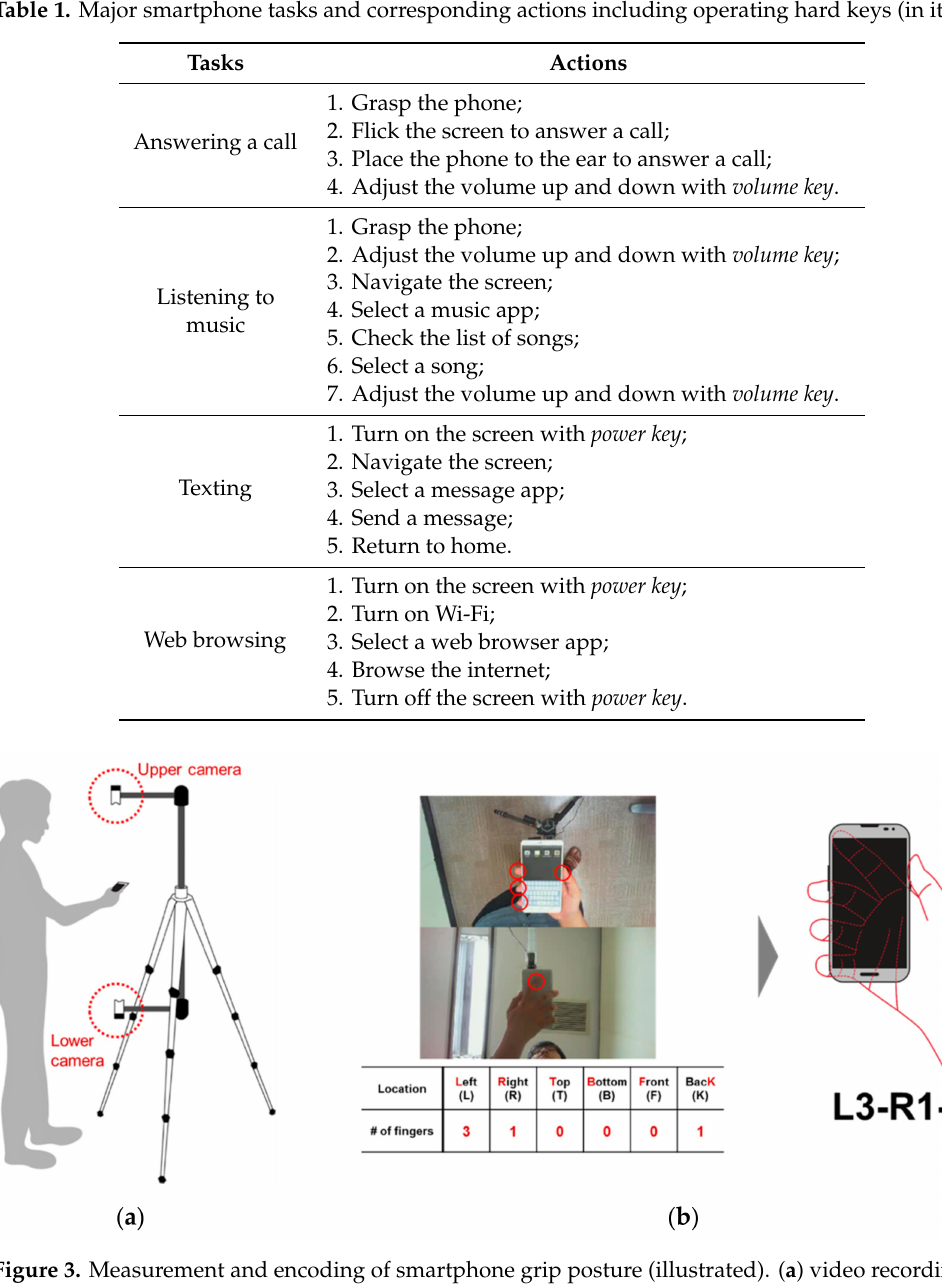
Figure 3. Measurement and encoding of smartphone grip posture (illustrated). ( a ) video recording of grip posture; ( b ) coding of grip